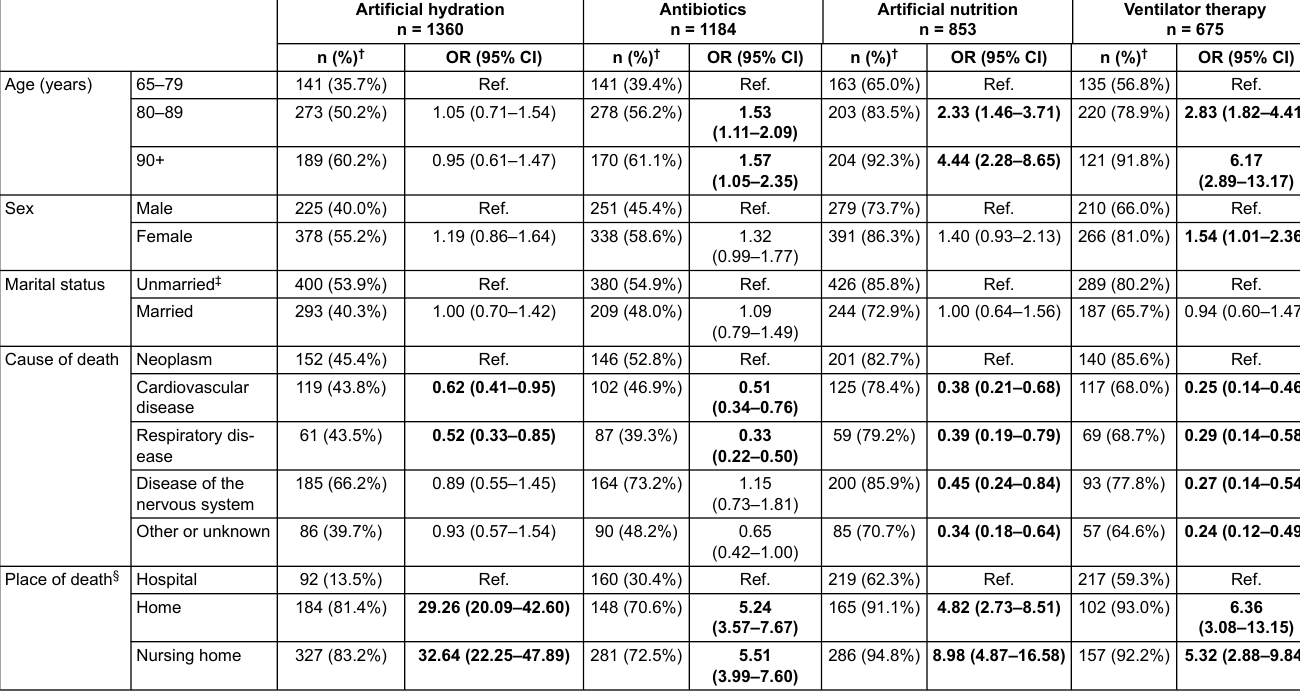
Table 3: Withholding the four most common types of treatment compared to those for whom treatment was continued or withdrawn * : multi-variable logistic